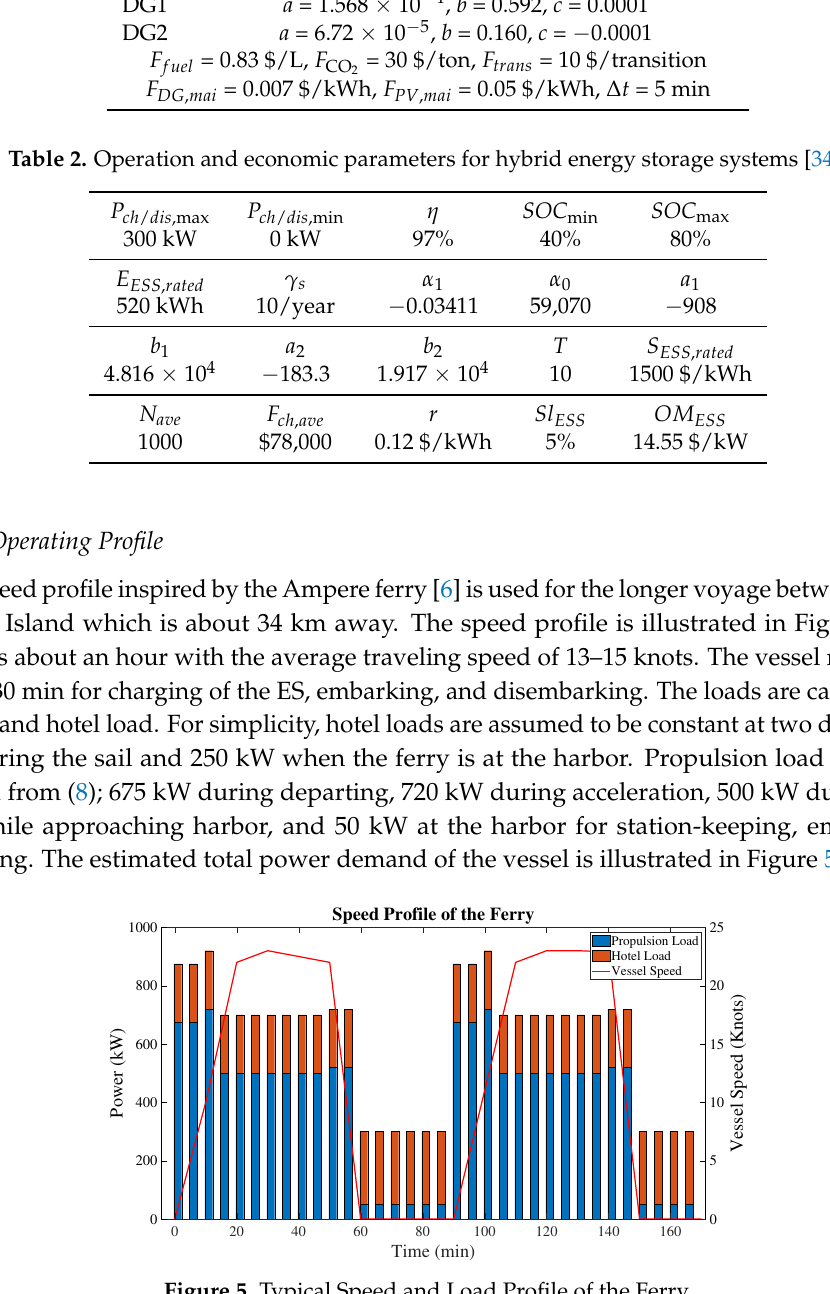
Table 1. Operation and economic parameters for diesel generator, grid, and photovoltaic (PV) [32,33]. Unit P max (kW) P min (kW) T min (min) P ramp ,max DG1 450 200 15 200 (kW/ ∆ t ) DG2 450 200 15 200 (kW/ ∆ t ) Grid 300 0 – – DG1 a = 1.568 × 10 − 4 , b = 0.592, c = 0.0001 DG2